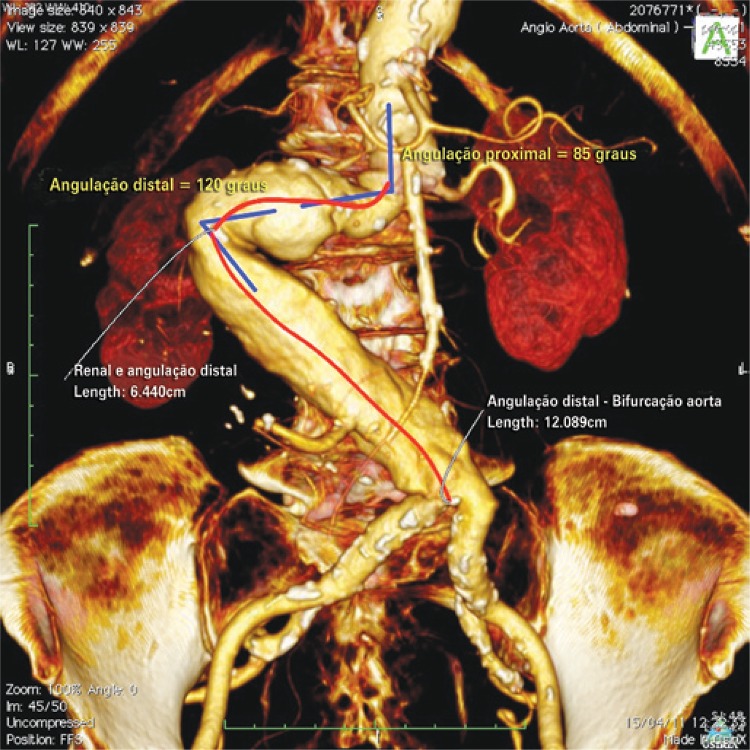
Angiotomografia pré-operatória evidenciando comprimento e tortuosidade do aneurisma